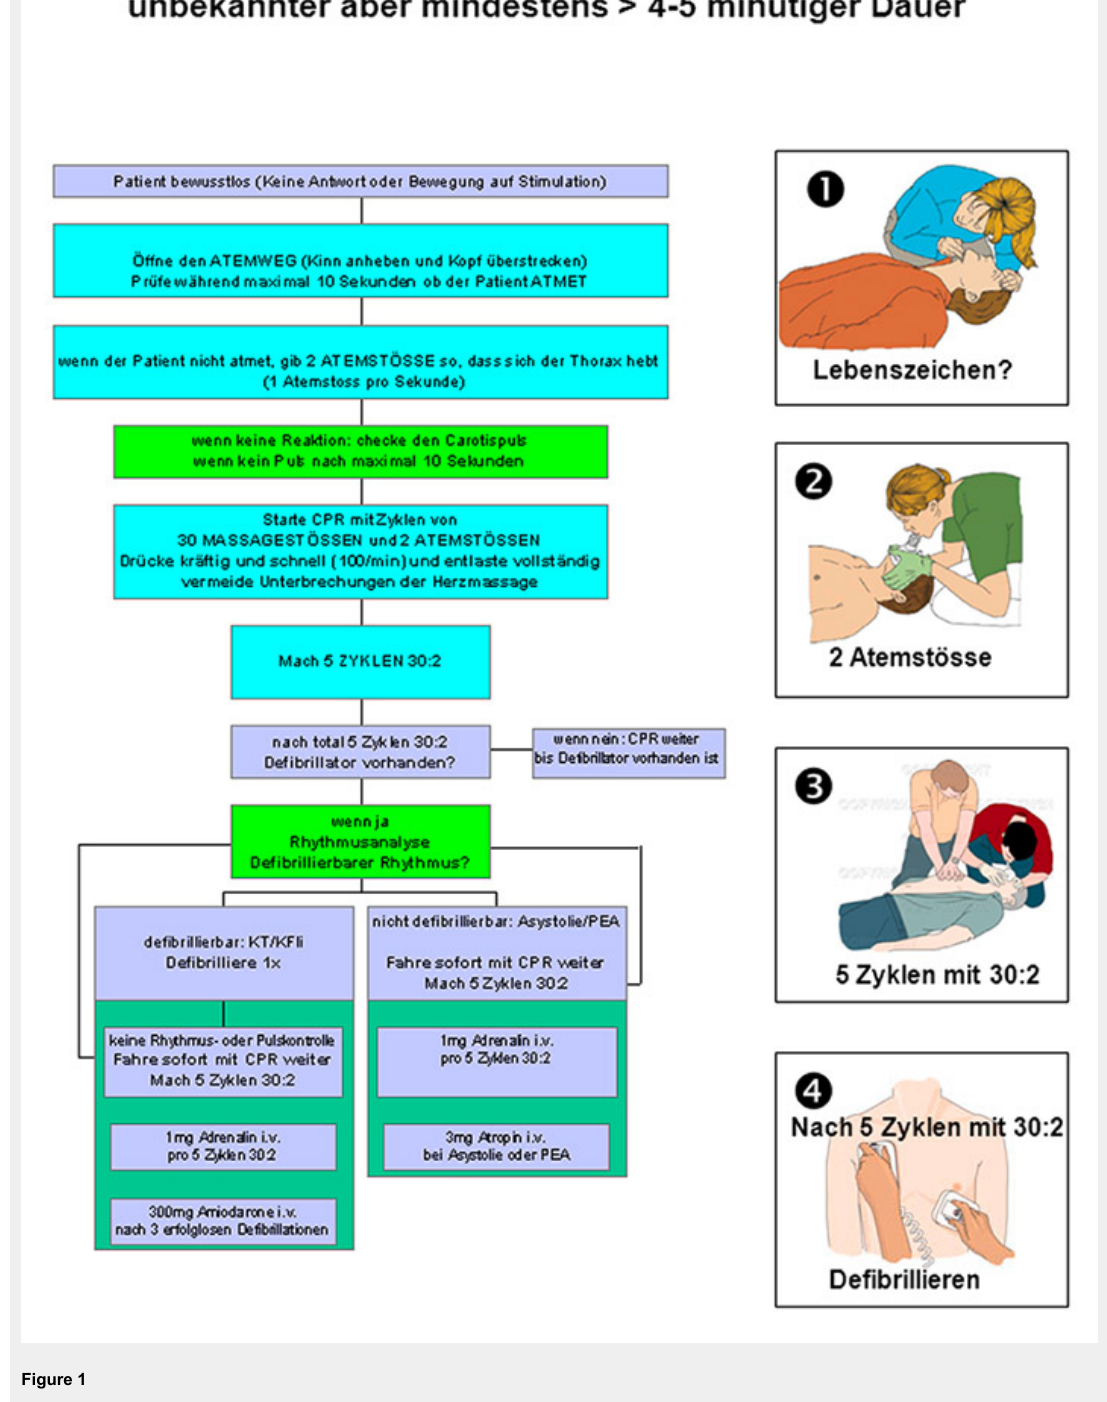
Instruction of the ABC algorithm corresponding to the 2005 guidelines of the American Heart Association [8]. The instruction includes illustrations from the electronic version of the 2005 guidelines of the American Heart Association [8] and the European Resuscitation Council [6]. Reprint with permission of the